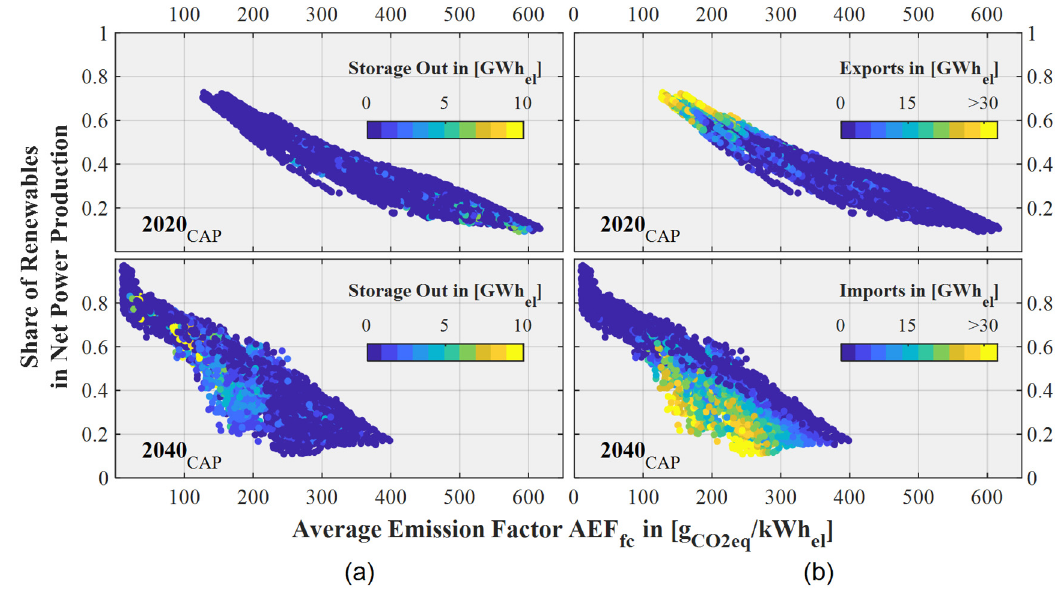
Figure 7. ( a ) Connection of the AEF fc with the share of RES in net power production and the impact of discharging processes; and ( b ) power exchanges (both with color scale). Model results.